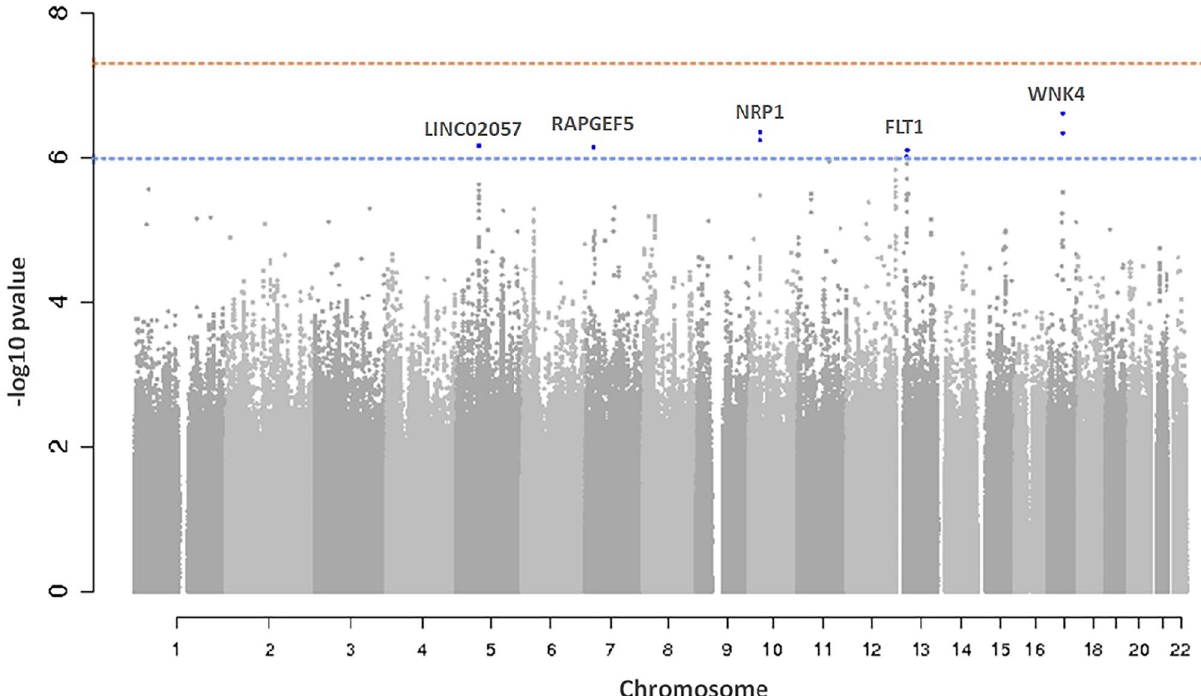
Figure 1. Manhattan plot of genome-wide association results in discovery analysis. Manhattan Plot showing − log10( p -values) for all SNPs of the PlGF discovery GWAS ordered by their chromosomal position. The blue dashed line indicates the suggestive association threshold ( p -value < 1 × 10 –6 ), while the red dashed line indicates the genome-wide significant threshold ( p -value < 5 × 10 –8 ). Blue dots are the SNPs associated at the suggestive significance level ( p -value < 1 × 10 –6 ). For each locus, the nearest gene is reported.